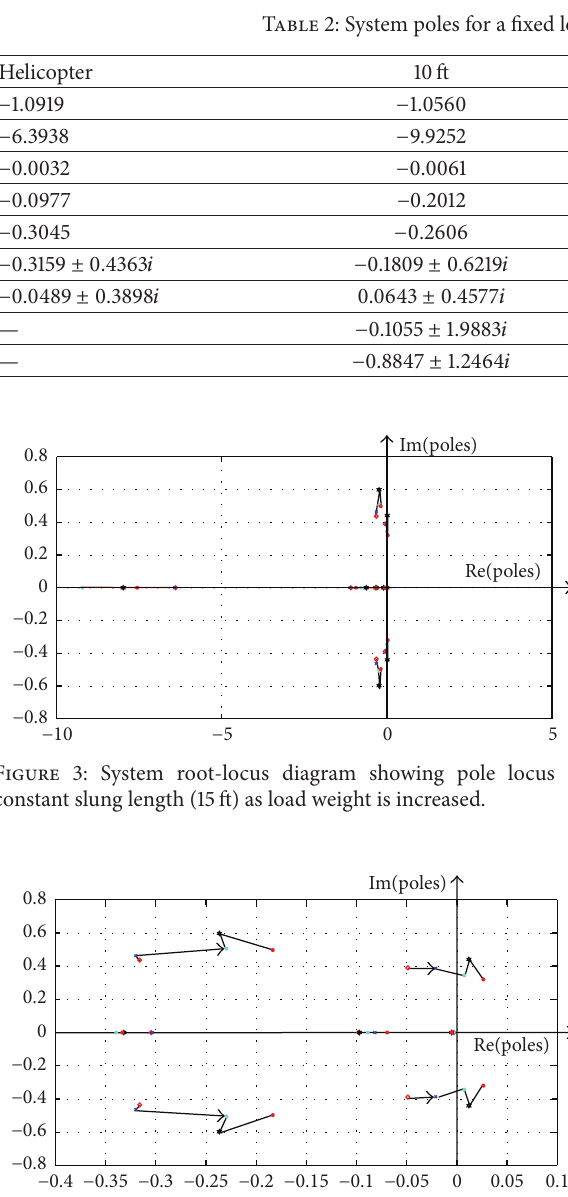
Figure 4: Enlarged view of Figure 3 showing poles locus near to Re(poles) = 0 axis.